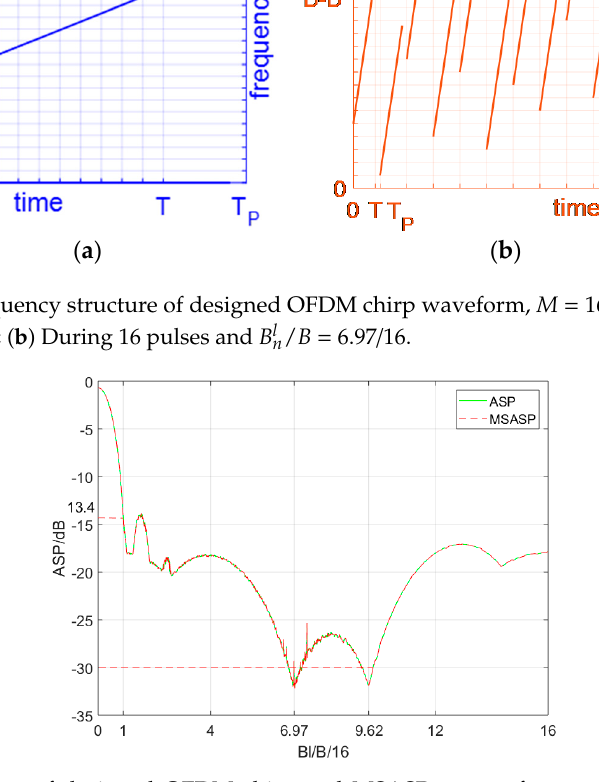
Figure 7. ASP curve of designed OFDM chirp and MSASP curve of conventional OFDM chirp with B l n / B